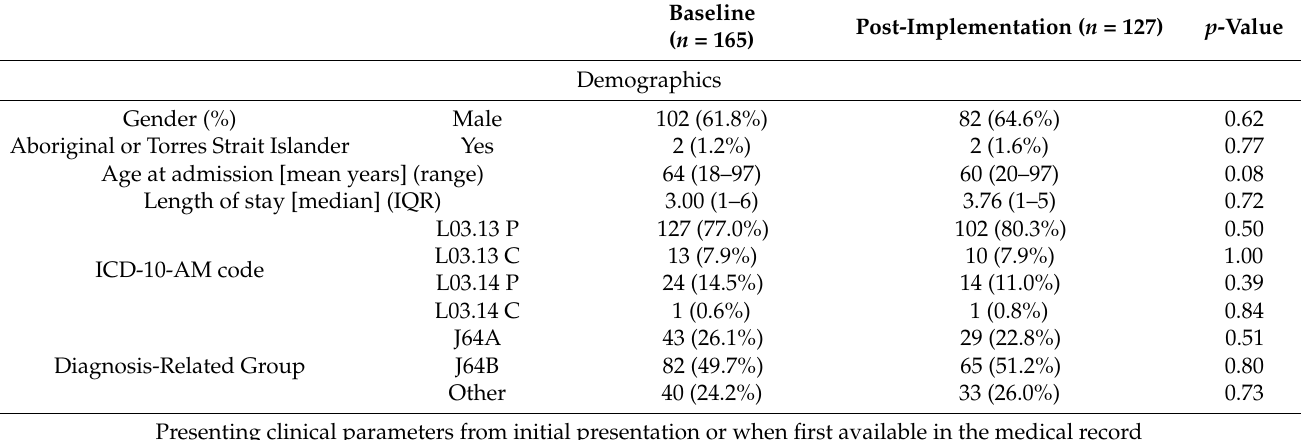
Table 1. Demographics, presenting clinical parameters, and comorbidities of patients included in the baseline and post- implementation